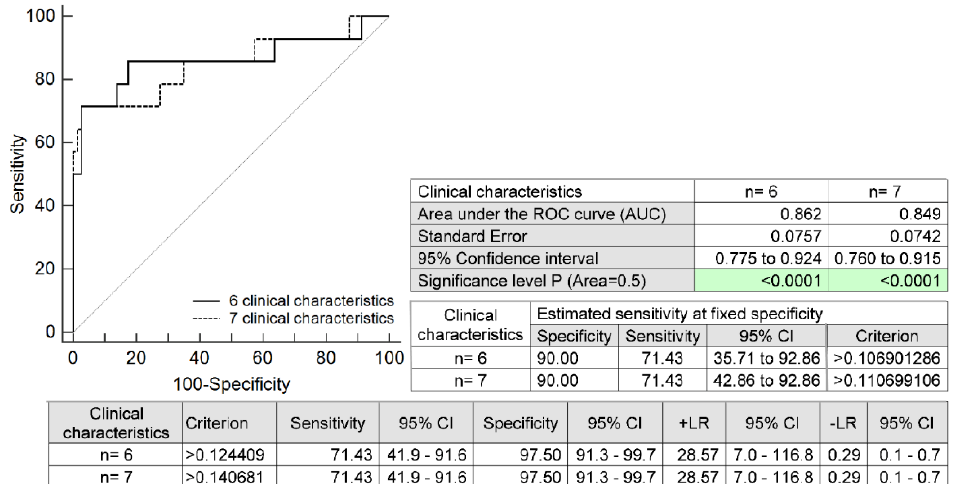
Figure 3. ROC analysis: the combination of six maternal clinical characteristics (maternal age and BMI values at early gestational stages, the presence of any autoimmune disease, an infertility treatment by assisted reproductive technologies, the occurrence of HELLP syndrome and/or PE in a previous gestation, and the presence of mutations in trombophilic genes). In the case of the combination of seven maternal clinical characteristics, the positivity of first-trimester PE/FGR screening by FMF was added. With a 10.0% FPR, 71.43% of pregnancies destined to develop HELLP syndrome were correctly identified. CI, confidence interval; +LR, positive likelihood ratio; − LR, negative likelihood ratio; BMI, body mass index; PE, pre-eclampsia; FGR, fetal growth restriction; FMF, Fetal Medicine Foundation; FPR, false-positive